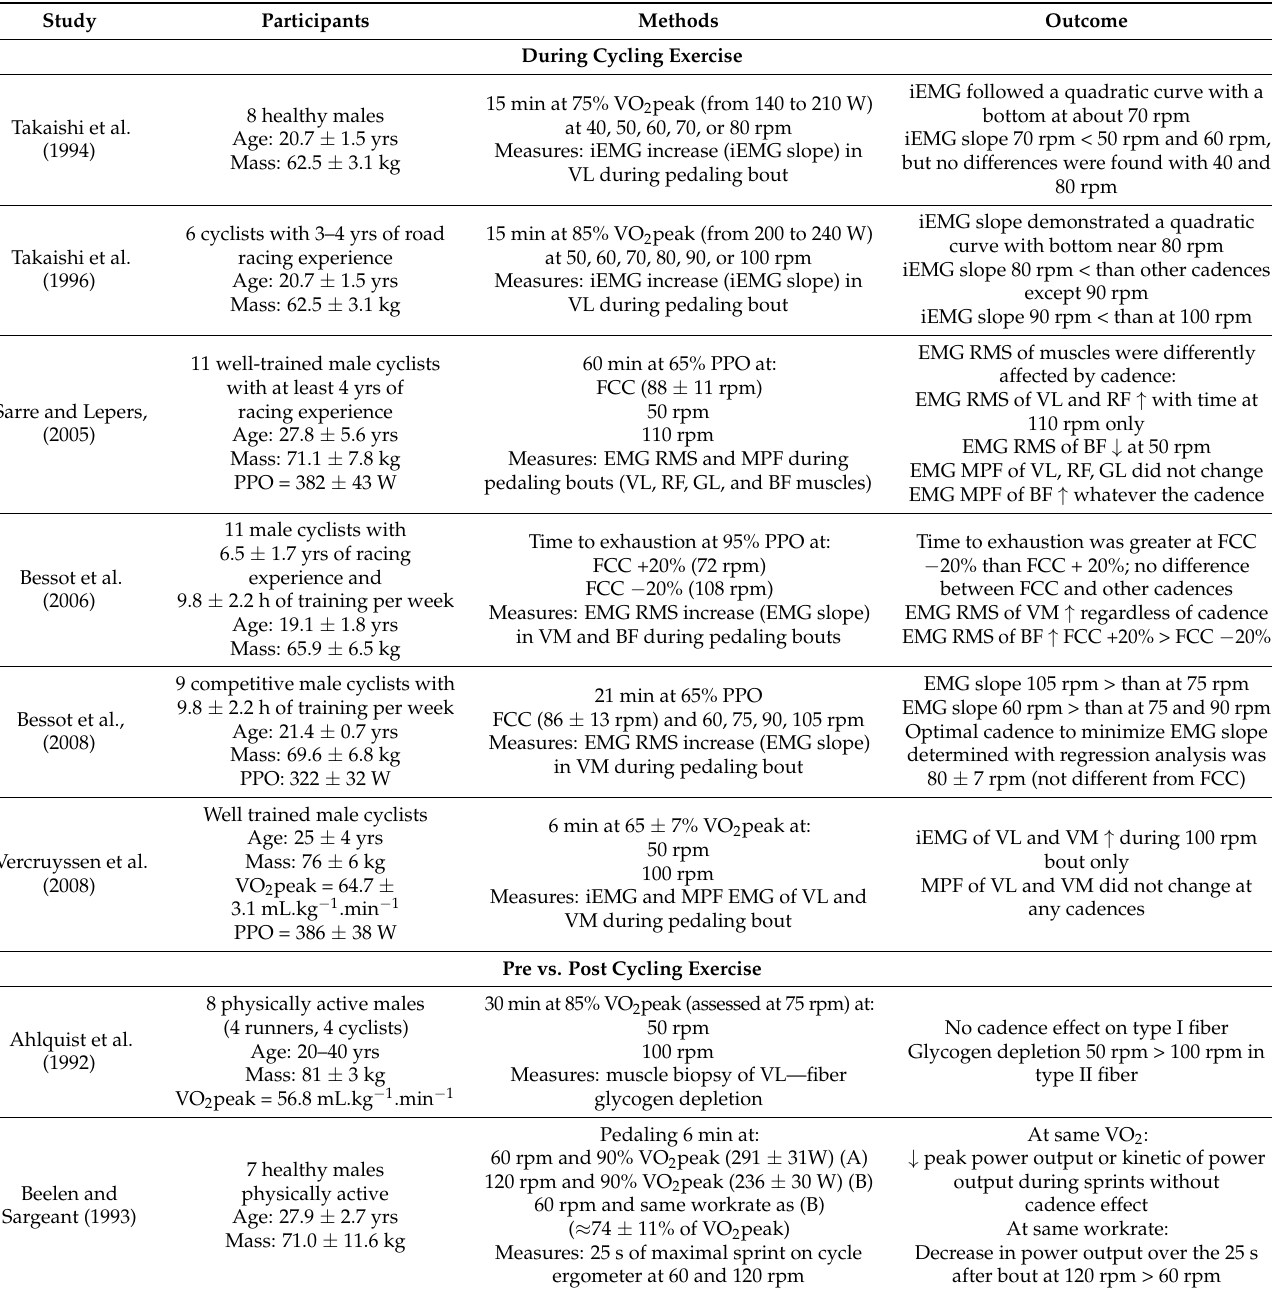
Table 1. Effect of pedaling cadence on the acute neuromuscular alteration (FCC: freely chosen cadence, PPO: peak power output, rpm: rotation per minute, EMG: electromyogram, RMS: root mean square, MPF: mean power frequency, MVC: maximal voluntary contraction, CON120 and CON240: concentric contraction at 120 and 240 ◦ .s − 1 , ISO: isometric contraction, VL: vastus lateralis, GL: gastrocnemius lateralis, RF: rectus femoris, iEMG: integrated electromyographic activity, HR max : maximal heart rate, and RM: repetition